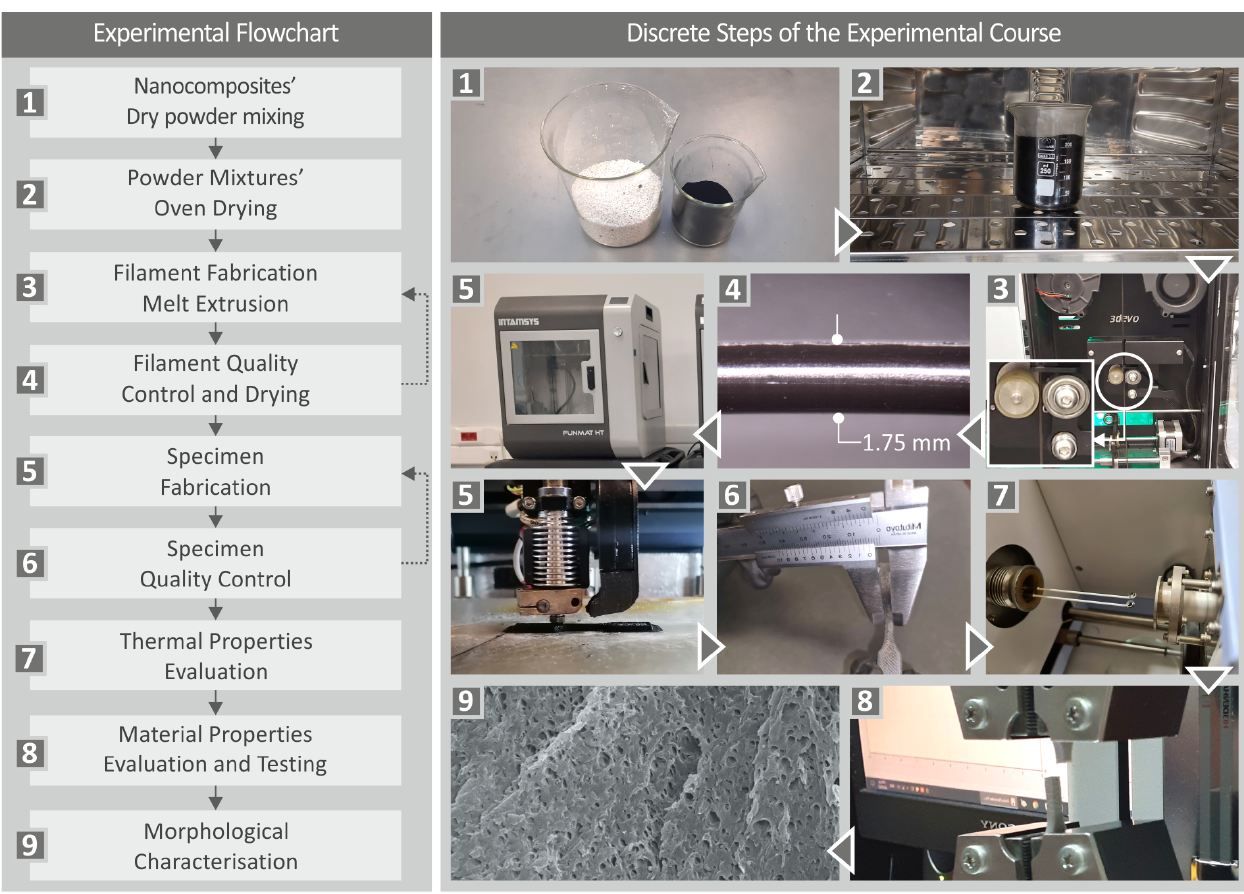
Figure 1. Workflow of experimental procedure: Flowchart of the experimental process and screenshots of the corresponding experimental steps followed.